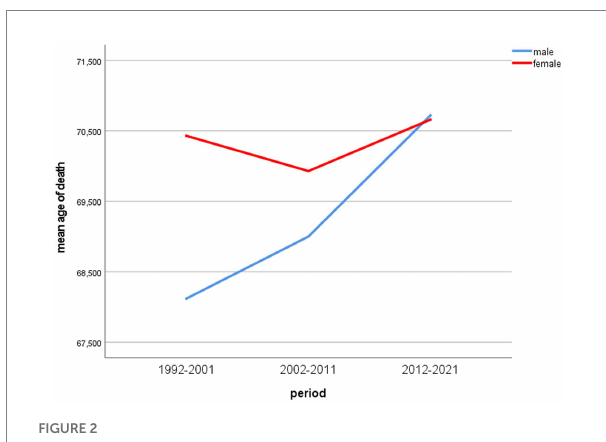
FIGURE 2 Mean age of death of male and female lung cancer patients 1992–